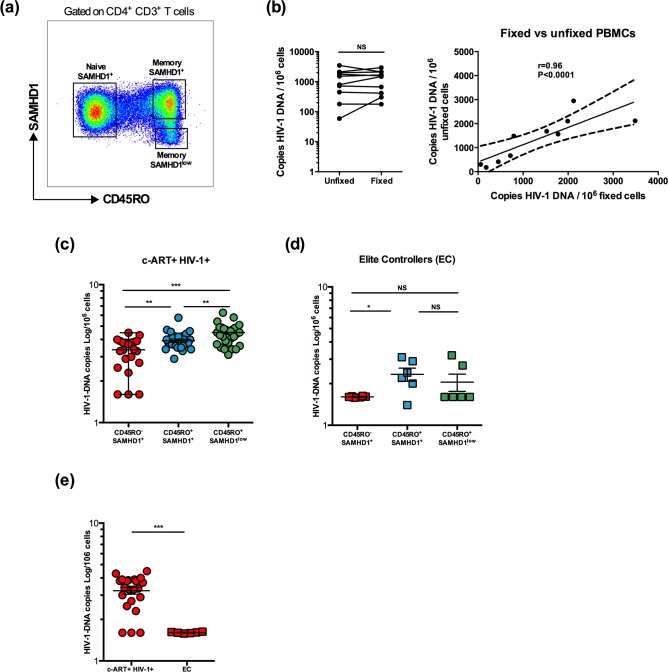
Memory CD4+ CD45RO+ SAMHD1low cells exhibit the highest level of HIV-1 DNA.Peripheral blood samples were collected from 36 HIV-infected individuals receiving c-ART and 6 Elite Controllers. Fresh PBMCs were stained with anti-CD3, -CD4, -CD45RO and -SAMHD1. The three cell subsets: memory CD4+ CD45RO+ SAMHD1low, CD4+ CD45RO+ SAMHD1+ and naive CD4+ CD45RO- SAMHD1+ were sorted by FACS. Protocols for DNA extraction and PCR experiments on permeabilized and fixed cells have been optimized using bulk PBMCs from 10 HIV-1 infected individuals receiving c-ART. Levels of total HIV-1 DNA were quantified by Nested real-time PCR in sorted cells ex vivo. (a) Gating strategy for memory CD4+CD45RO+SAMHD1low, CD4+CD45RO+SAMHD1+ and naive CD4+CD45RO-SAMHD1+. (b) Levels of total HIV-1 DNA in unfixed PBMCs from HIV-1 infected individuals receiving c-ART (n = 10) compared head-to-head with fixed PBMCs from the same individuals. (c) Levels of total HIV-1 DNA in sorted memory CD4+CD45RO+SAMHD1low, CD4+CD45RO+SAMHD1+ and naive CD4+CD45RO-SAMHD1+ from HIV-1 infected individuals receiving c-ART. (d) Levels of total HIV-1 DNA in sorted memory CD4+CD45RO+SAMHD1low, CD4+CD45RO+SAMHD1+ and naive CD4+CD45RO-SAMHD1+ from Elite Controllers (HIV+ EC). (e) Levels of total HIV-1 DNA in sorted naive CD4+CD45RO-SAMHD1+ from HIV-1 infected individuals receiving c-ART and Elite Controllers. Data represent median with interquartile range. *p<0.05, **p<0.01 and ***p<0.001, t-test and 2-way ANOVA tests followed by Bonferroni post-tests.